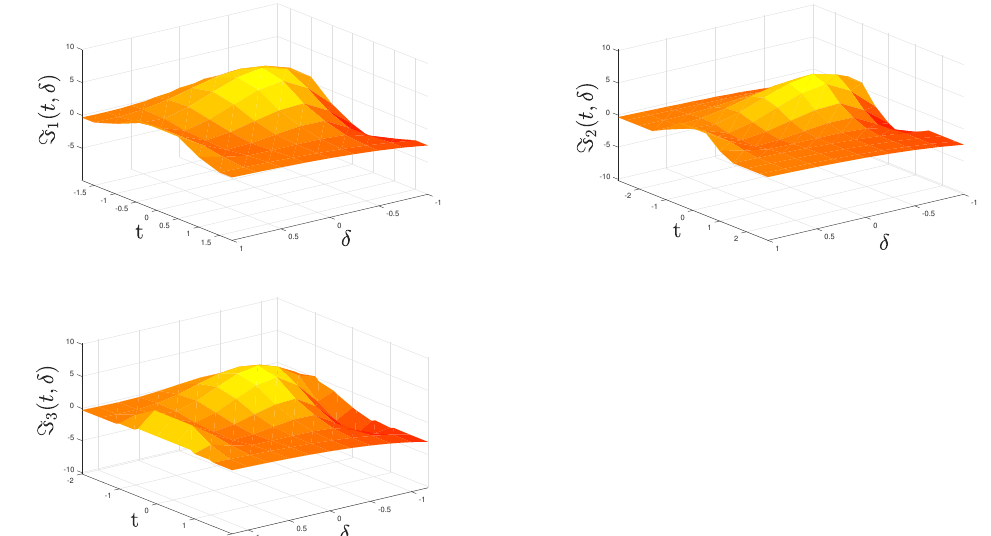
Figure 5. The state trajectories of the corresponding error system of the type (8) in Example 2 with controller (7) for τ = 3.